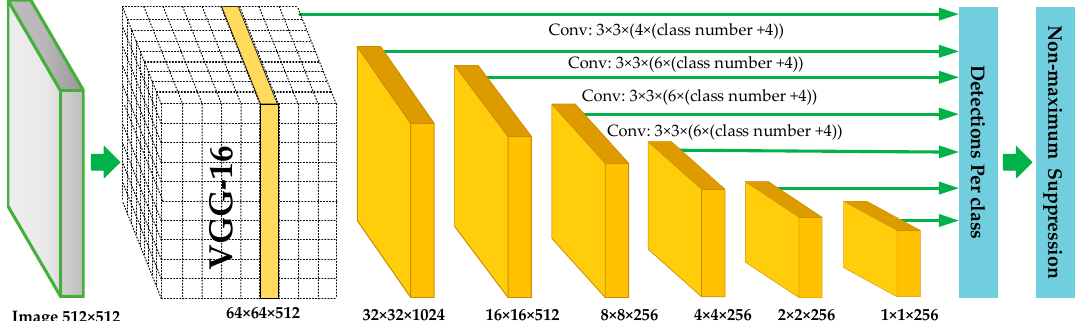
Figure 5. The network model for signal modulation recognition.